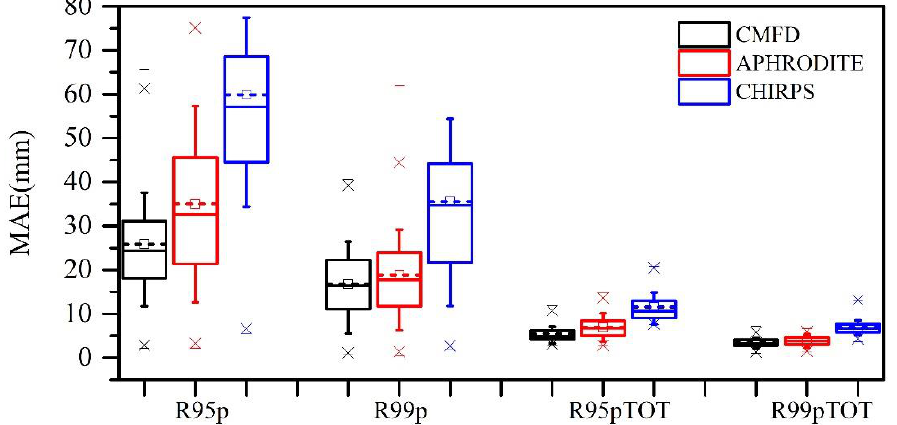
Figure 10. Boxplots of the mean absolute error (MAE) for gauge-based station threshold indices R95p, R99p, R95pTOT, and R99pTOT, as derived from CMFD, APHRODITE, and CHIRPS at 101 rain gauges. Five lines from bottom to top for one box represent minimum value, 25th percentile, 50th percentile, 75th percentile, and maximum value, respectively. The quadrate inside the box represents the mean values. The asterisks represent several possible alternative